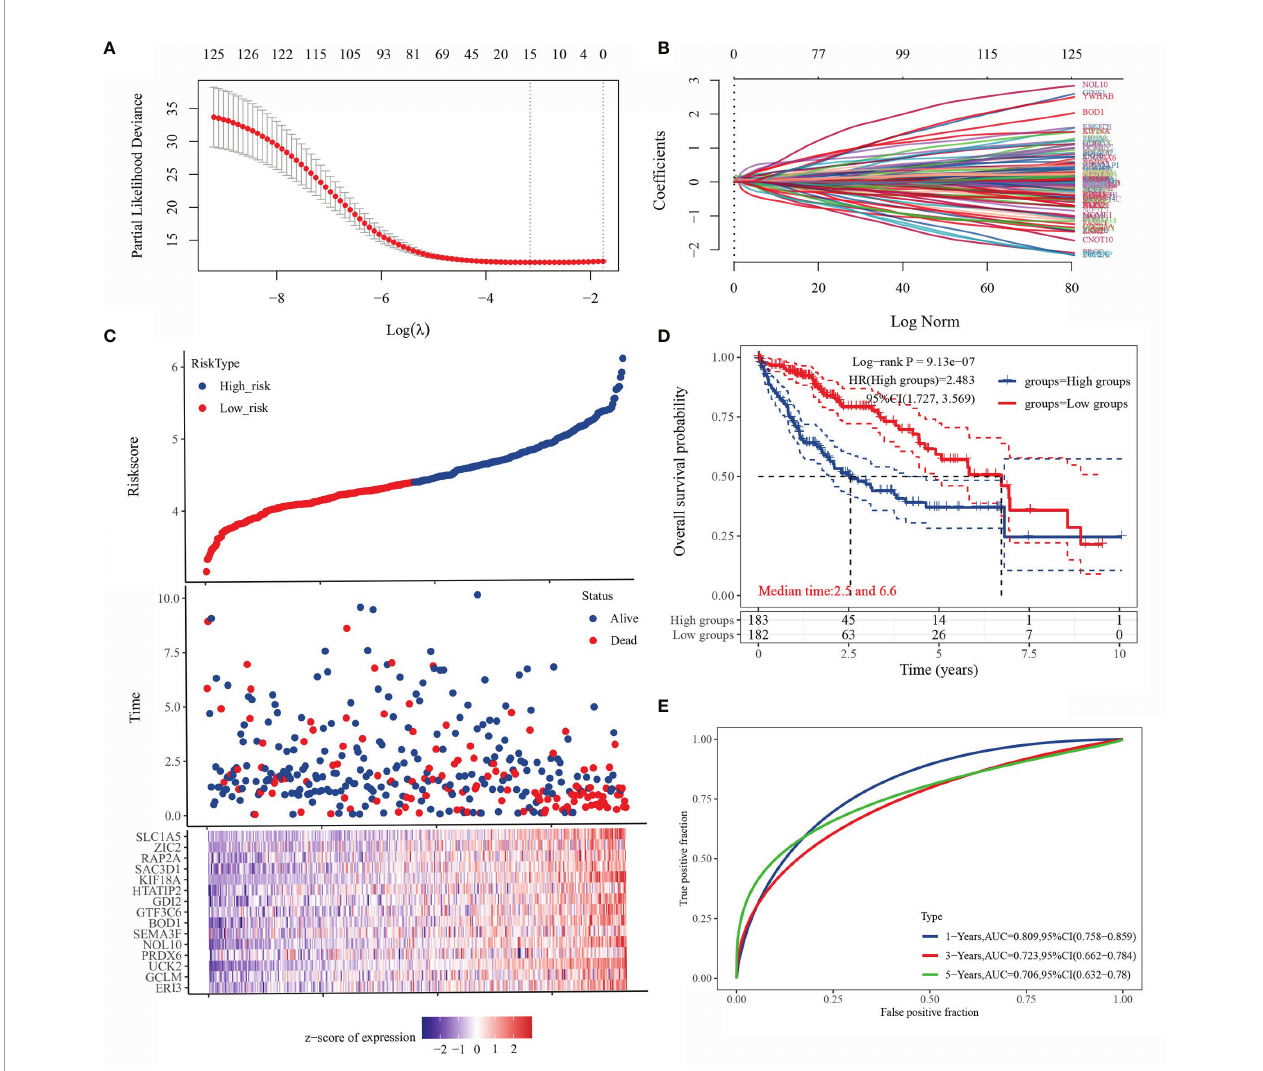
FIGURE 4 | Prognostic model based on LASSO regression algorithm. [ (A) partial likelihood deviation plotted against log( l ) using the LASSO-Cox regression model; (B) coef fi cients of selected features are shown by the lambda parameter, the horizontal axis represents the value of the independent variable lambda and the vertical axis represents the coef fi cients of the independent variable; [ (C) Risk score and survival time and survival status cases; (D) this risk model in the TCGA KM survival curve distribution; (E) ROC curves with AUC at different times for this risk